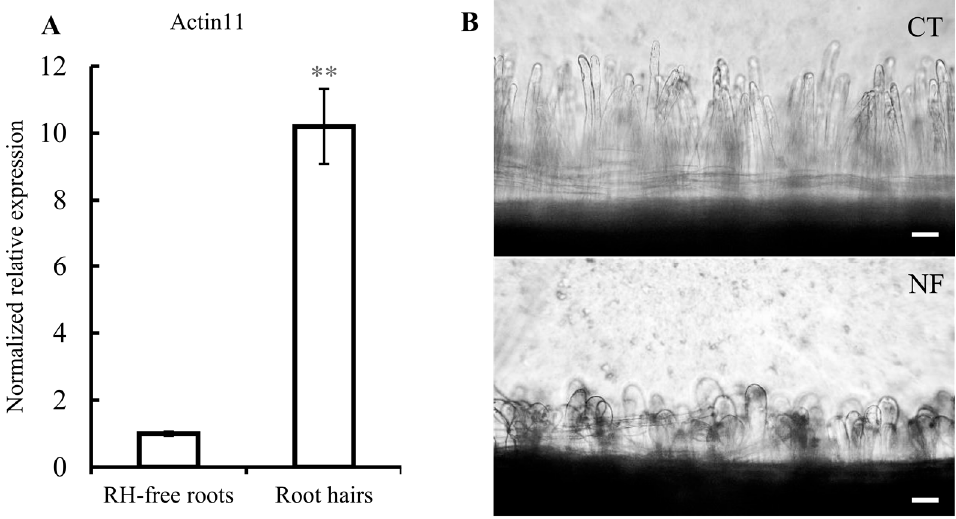
Figure 1. Cont. Figure 1.